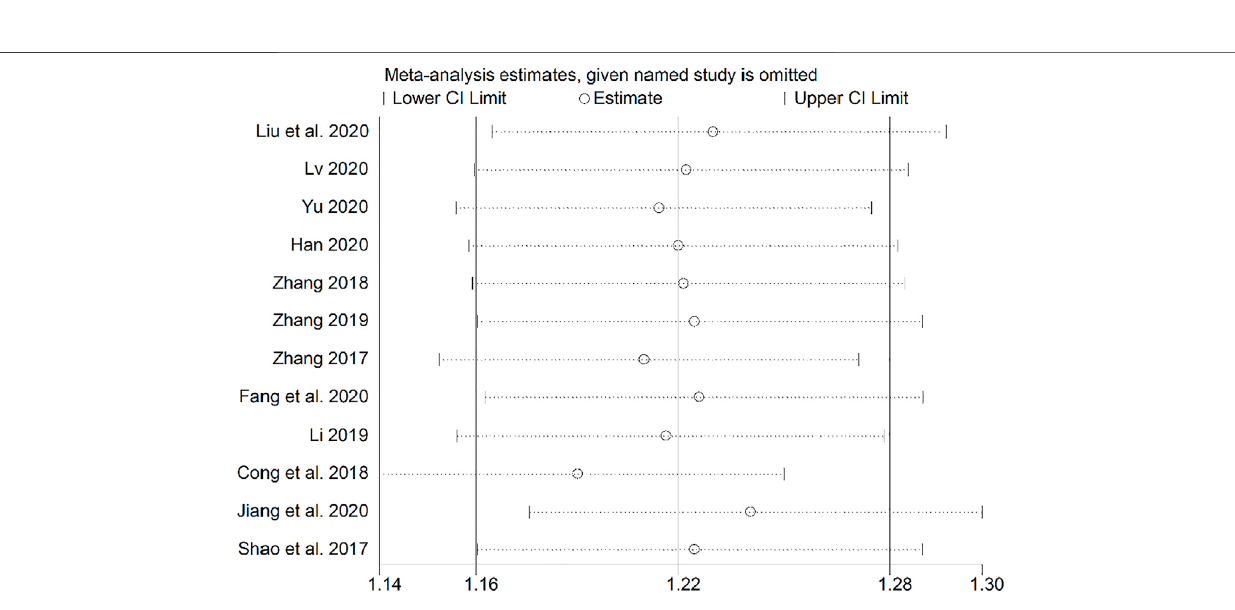
Frontiers in Pharmacology |